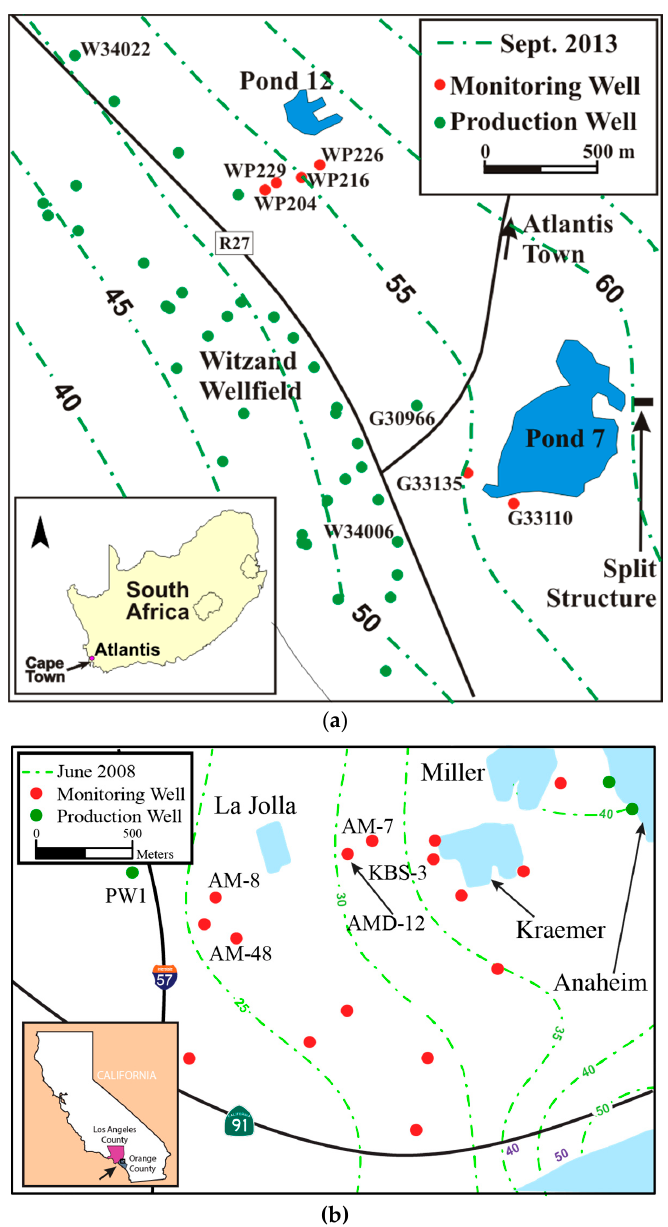
Figure 1. Maps of the field areas including locations of infiltration basins, production and monitoring wells, and local piezometric surface. ( a ) The Atlantis Managed Aquifer Recharge (MAR) site with an insert of South Africa and ( b ) the Orange County Water District (OCWD) MAR site down gradient from Kraemer Basin with an insert of California, USA. Please note that the approximate area of the OCWD MAR site is located on the California map with an arrow pointing at a small black rectangle.